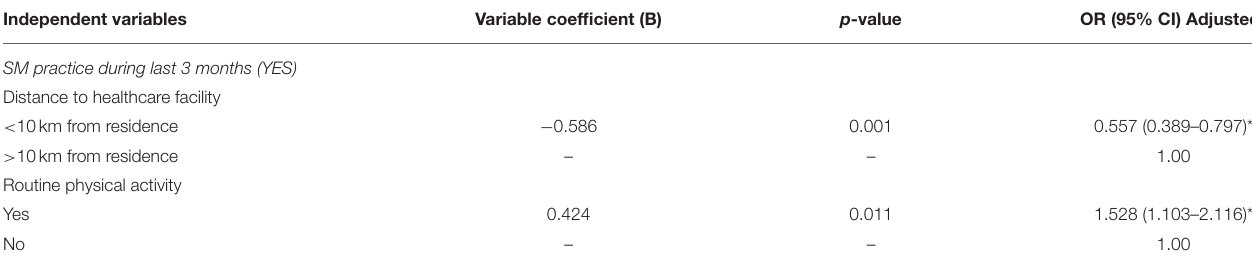
TABLE 5 | Multivariant logistic regression analysis identifying the variables associated with the self-medication during the last 3 months. Independent variables